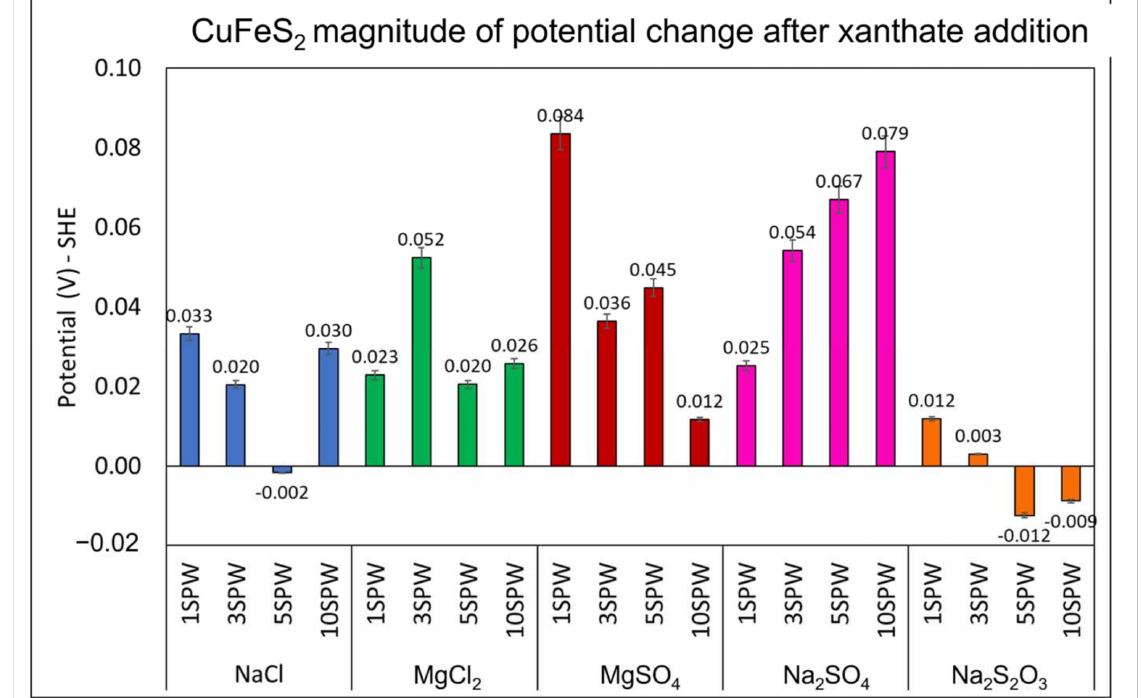
Figure 1. Extent of potential change after SEX addition for chalcopyrite with changing water